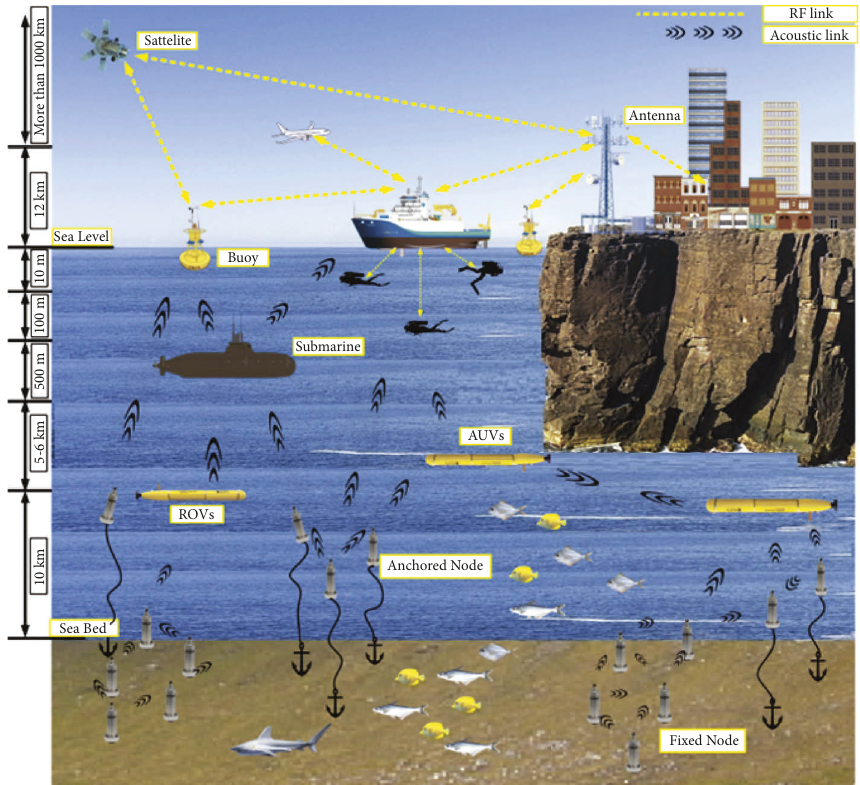
Figure 2: Real scenario of underwater wireless Communication with various